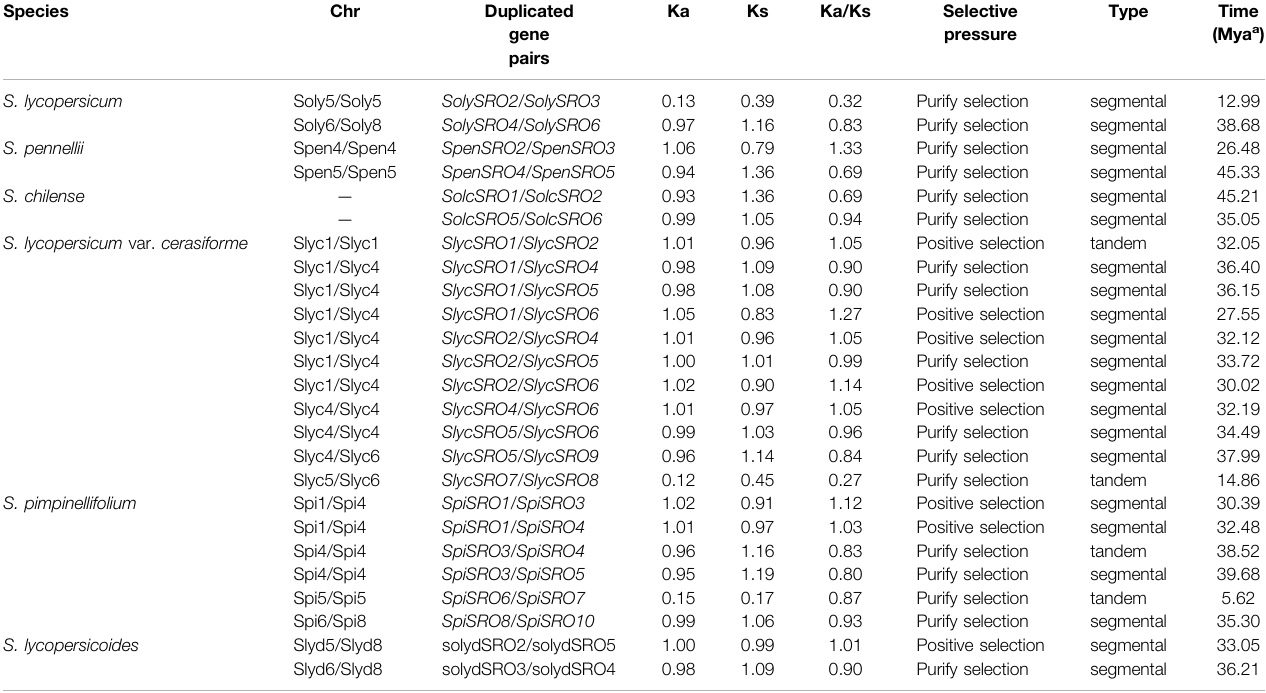
TABLE 2 | The Ka / Ks ratios and date of duplication for duplicate SRO genes in tomato. Species